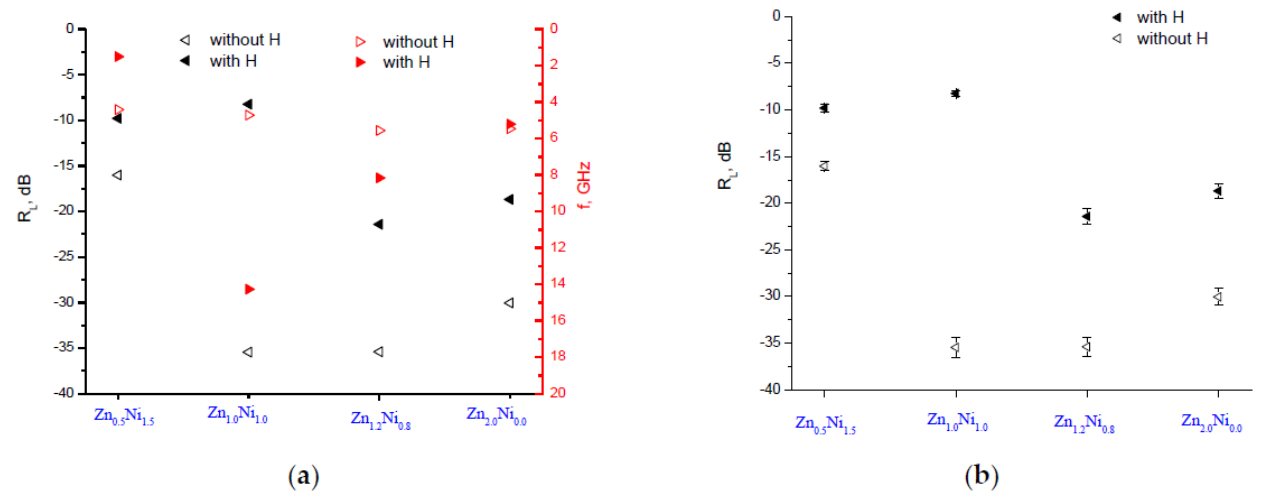
Figure 9. The main reflection loss peaks for the A series of samples depending on the Zn:Ni ratio ( a ) without a magnetic field and ( b ) with an external magnetic field applied.